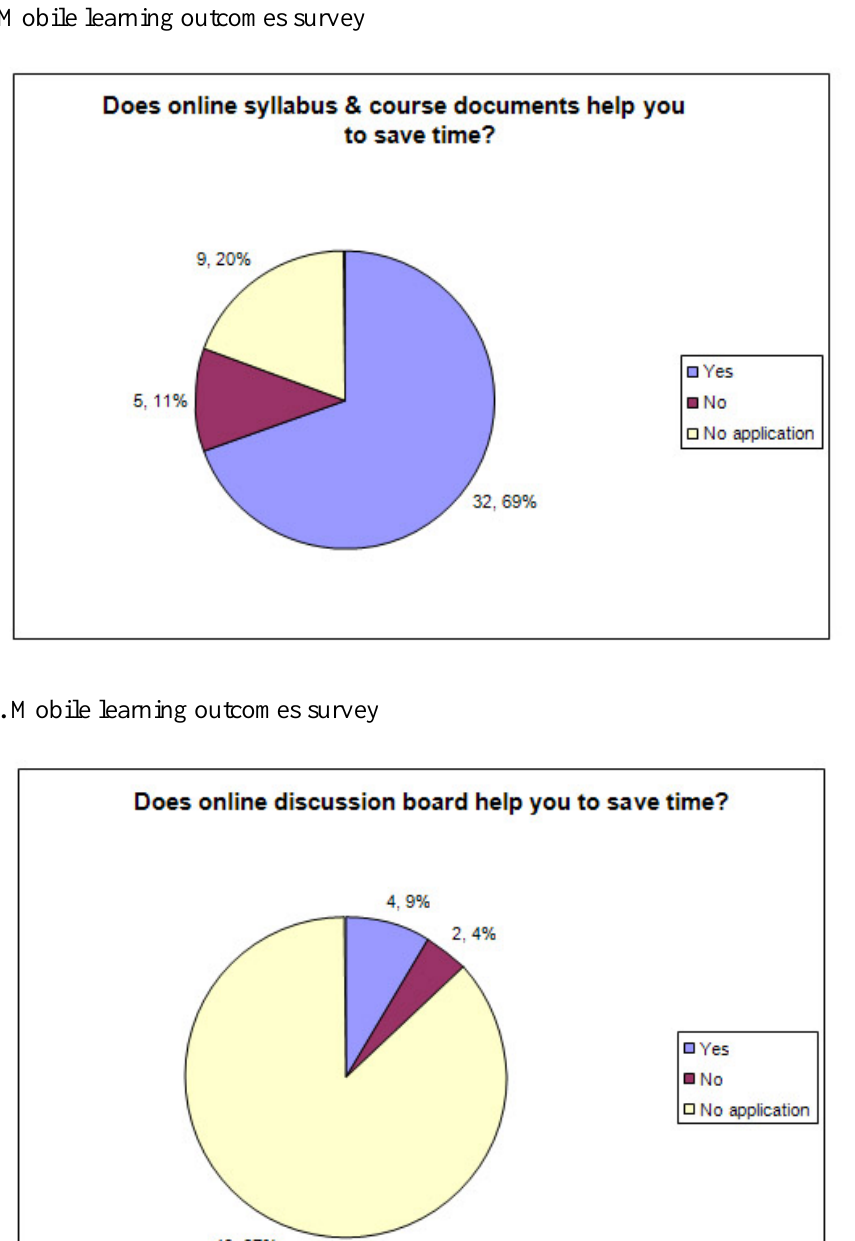
Figure 9. Mobile learning outcomes survey